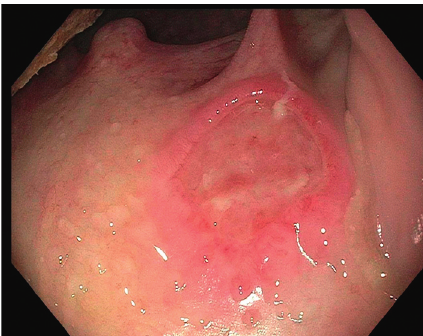
Figure 1: Soft palate ulcer in the right oropharynx, which was biopsied and revealed nonspecific findings of acute and chronic inflammation.